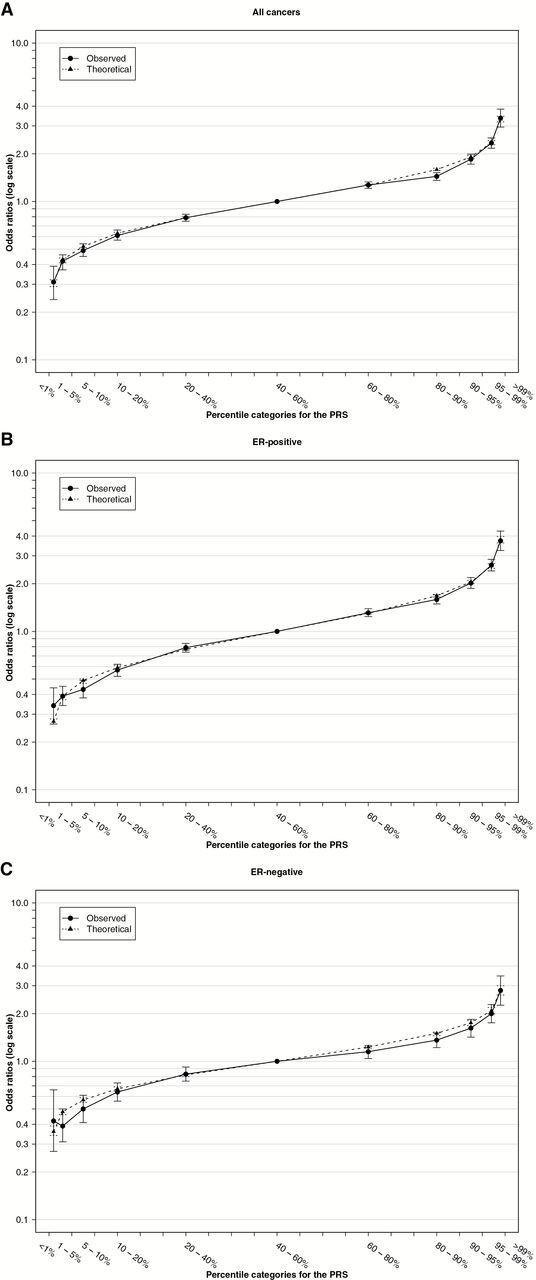
Association between the polygenic risk score (PRS) and breast cancer risk in women of European origin for (A) all breast cancers, (B) estrogen receptor (ER)–positive disease, and (C) ER-negative disease. Odds ratios are for different percentiles of the PRS relative to the middle quintile (40% to 60%) of the PRS. Odds ratios and 95% confidence intervals are shown. Regular lines denote the observed estimates, and dotted lines the theoretical estimates under a multiplicative polygenic model with a standard deviation of the PRS of 0.45 for all breast cancer, 0.50 for ER-positive breast cancer, and 0.38 for ER-negative breast cancer, as derived from the estimated effect sizes and allele frequencies/haplotype frequencies for each locus. PRS = polygenic risk score.